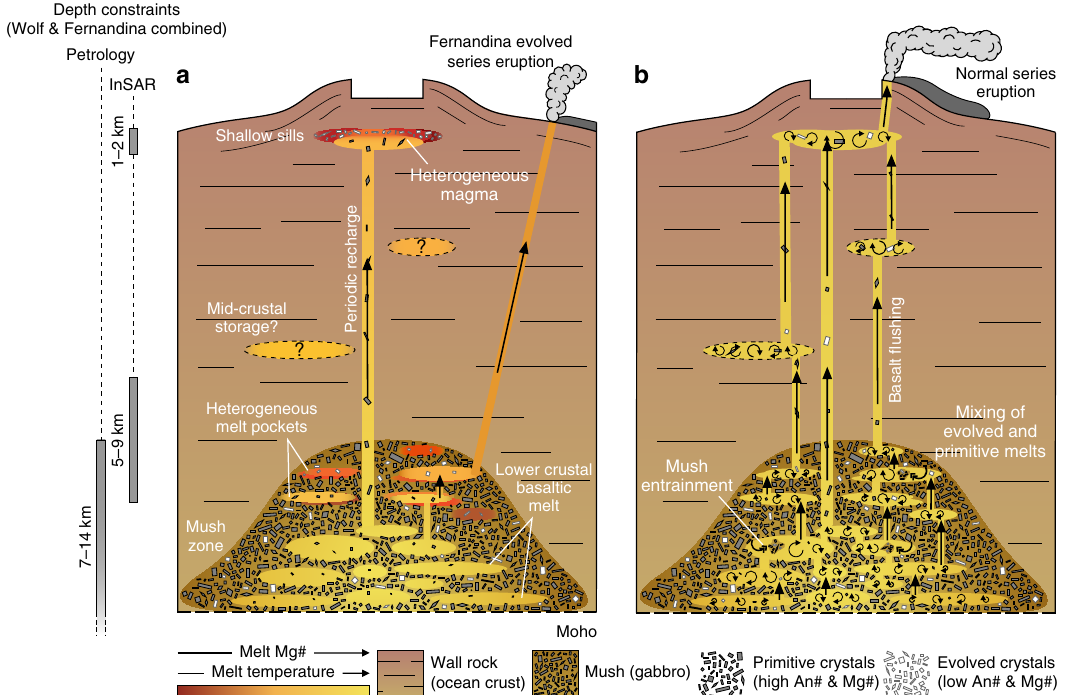
Fig. 10 Cartoon summarising the architecture of the Wolf and Fernandina plumbing systems. The grey bars (left) show relative estimates of magma storage depths at Wolf and Fernandina from Interferometric Synthetic Aperture Radar (InSAR) inversions and petrological barometry 19,21,32,33 . Not to scale. a The volcanoes are underlain by large lower crustal magma storage regions and smaller shallow storage regions, which are recharged by new magma ascending from depth. Both regions contain compositionally heterogeneous melts. We cannot discount mid-crustal magma storage but there is no petrological or geophysical evidence from recent eruptions. At Fernandina, evolved series submarine eruptions are periodically fed by melts ascending directly from the deeper storage region. b Large volumes of basaltic melt periodically ascend from depth, fl ushing through the systems and mixing with liquids stored at shallower levels. Some sub-volcanic mush is entrained into the ascending liquids. As the volume of ascending basalt is much greater than the volume of evolved material at shallower levels, its composition remains almost unaltered; only crystals that were not fully resorbed during mixing preserve evidence of the earlier